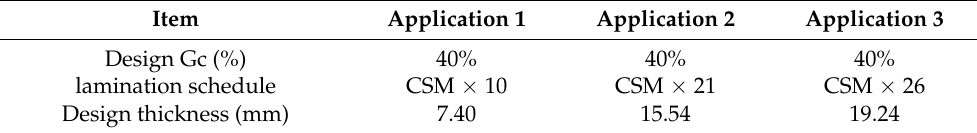
Table 2. Design properties of the hull plates used for thickness measurement error determination.